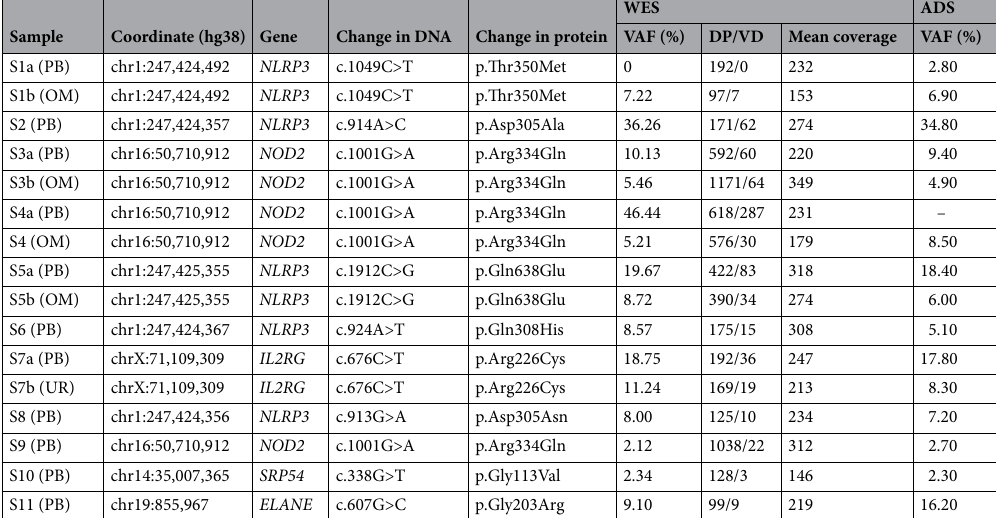
Table 1. Samples and mutations included in the study. VAFs from ADS were extracted from a previous publication 21 . DP total depth; VD variant